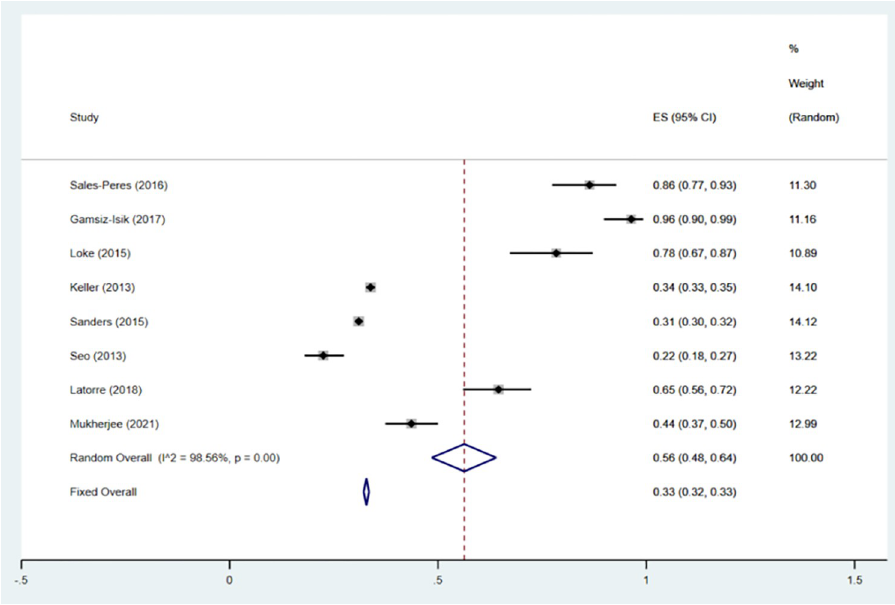
Fig 2. Forest plot of the incidence of periodontitis in OSA according to the results of eight studies.